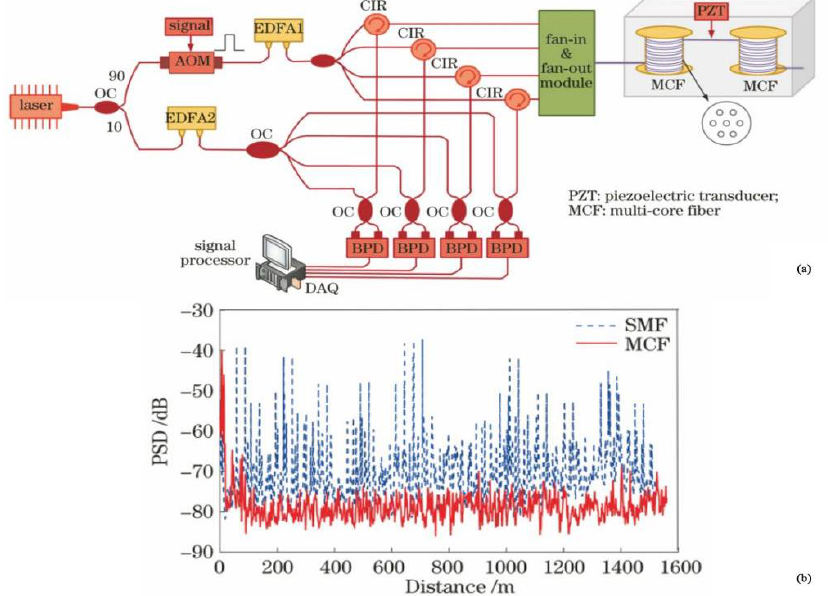
Figure 7. ( a ) Experimental setup. ( b ) PSD of SMF and MCF at the frequency of 2.5 kHz [36]. Table 1. Research progress for suppression of polarization